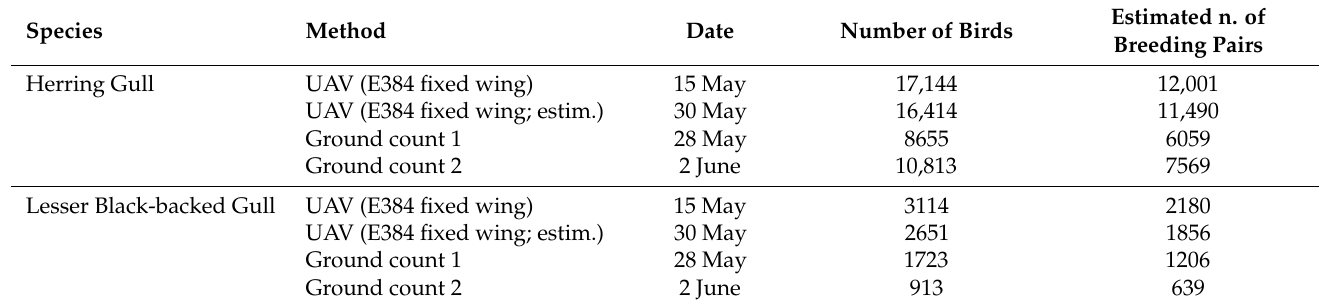
Table 4. Individuals counted (in total) and estimated number of breeding pairs (factor 0.7) using UAVs and traditional methods (ground counts of individuals) on the island of Langli during the period of study. Traditionally, the highest number of birds counted on the different ground counts is used as a survey result for the